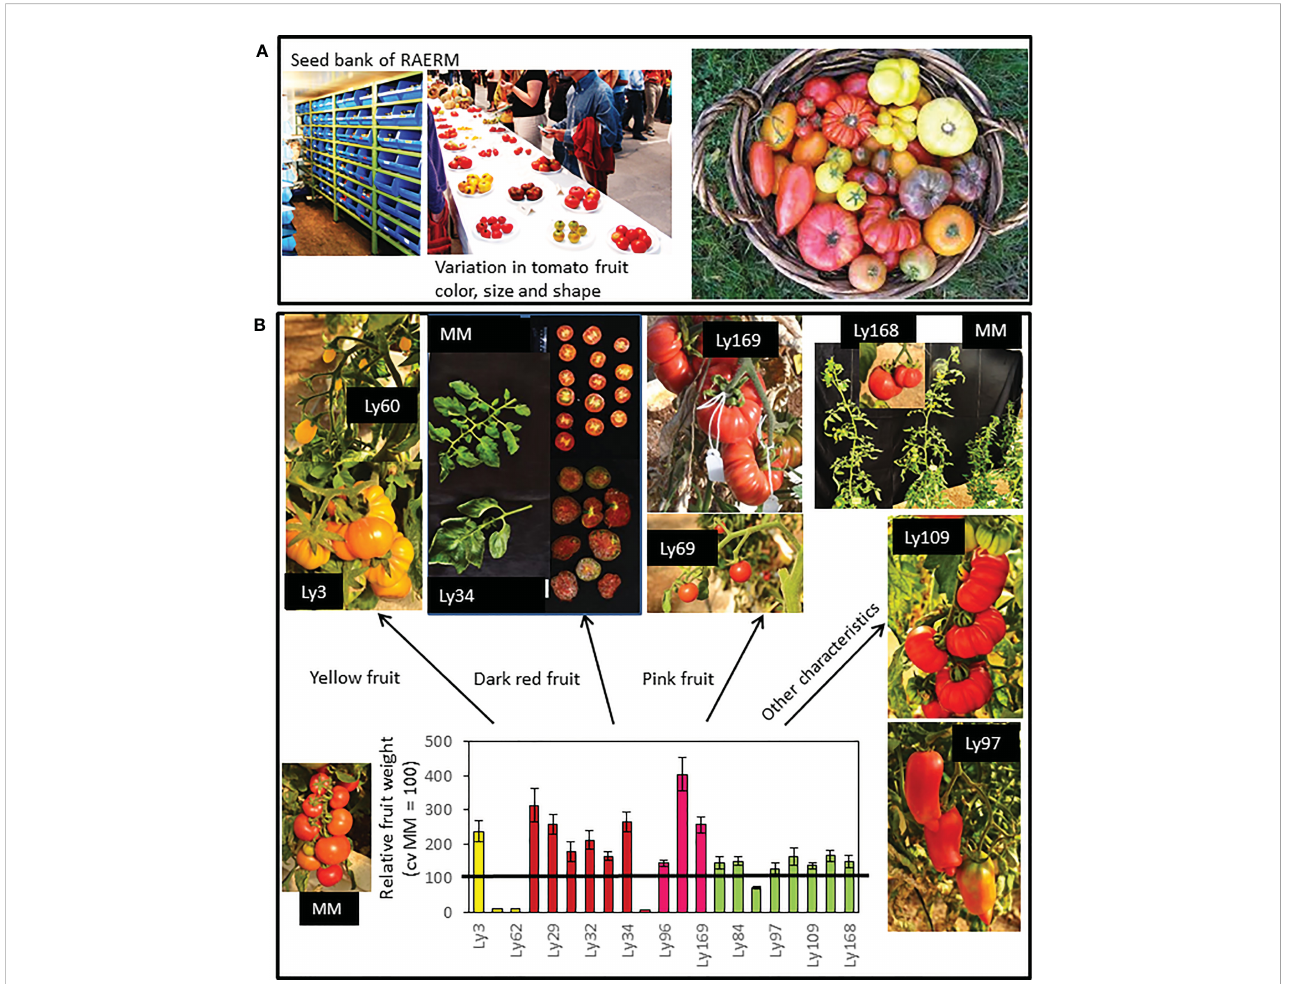
FIGURE 2 (A) Seed bank and a representative sample of the variation in fruit size, color and shape of tomato traditional varieties collected by the Agro-Ecology Network of the Region of Murcia (RAERM). (B) Representative pictures of varieties belonging to groups of tomatoes classi fi ed by the fruit size, fruit color and other characteristics. In the graphic the relative fruit weights with regard to commercial cv Moneymaker (MM, used as reference) are included. Sources: Flores et al., 2022. Recuperacio ́ n de variedades tradicionales de tomate de alta calidad de fruto para su cultivo en condiciones de la cuenca mediterra ́ nea. Avances en maduracio ́ n y poscosecha de frutas y hortalizas (E. Arias, S. Remo ́ n, R. Oria Eds., Servicio de Publicaciones-Universidad de Zaragoza, ISBN: 978-84-18321-41-2), pags 51-60. Meza et al., 2020. Traditional tomato varieties improve fruit quality without affecting fruit yield under moderate salt stress. Front. Plant Sci. 11:587754. doi: 10.3389/fpls.2020.587754. Massaretto et al., 2018. Recovering tomato landraces to simultaneously improve fruit yield and nutritional quality against salt stress. Front. Plant Sci. 9:1778. doi: